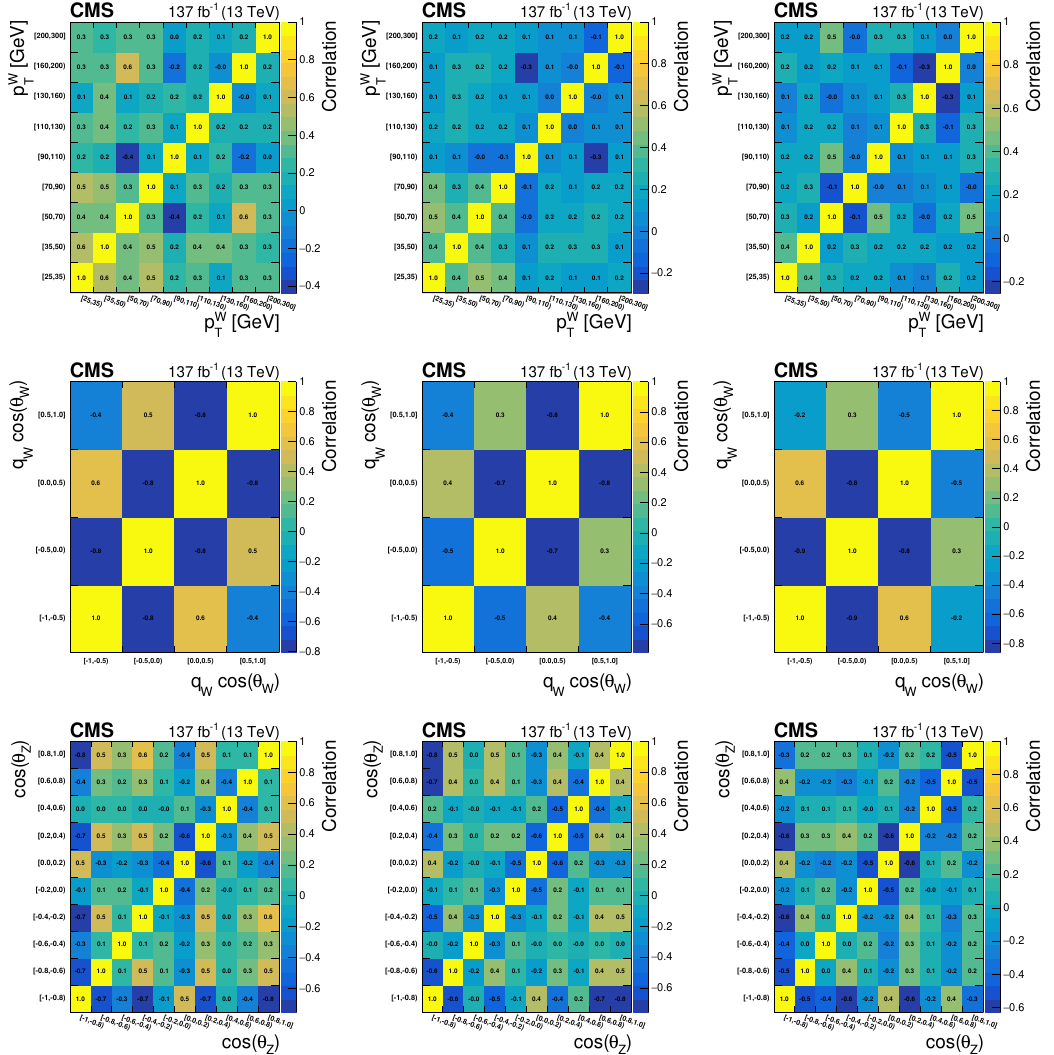
Figure 17 . Correlation matrices for the unfolded results using NNLO bias, area constraint, and no additional regularization term for several variables and charged final states. From top to bottom: of the lepton in the W boson decay, cosine of the polarization angle of the W boson, and cosine p T of the polarization angle of the Z boson. From left to right: charge-inclusive, positive-charge, and negative-charge final